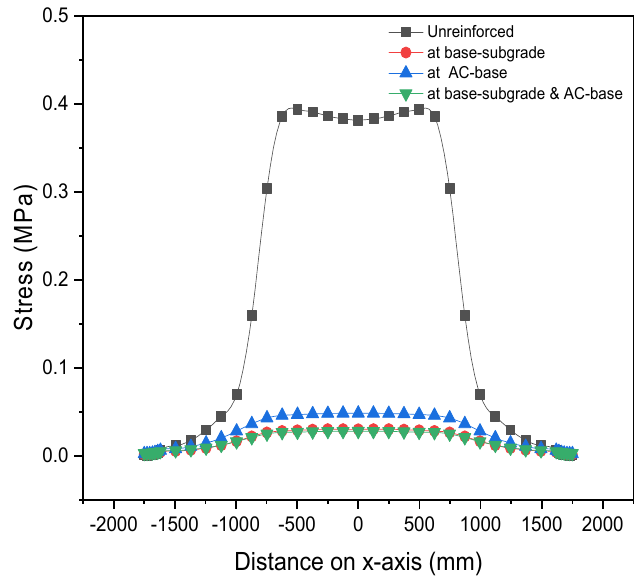
Figure 5. Comparison of stress distribution on top of the subgrade.